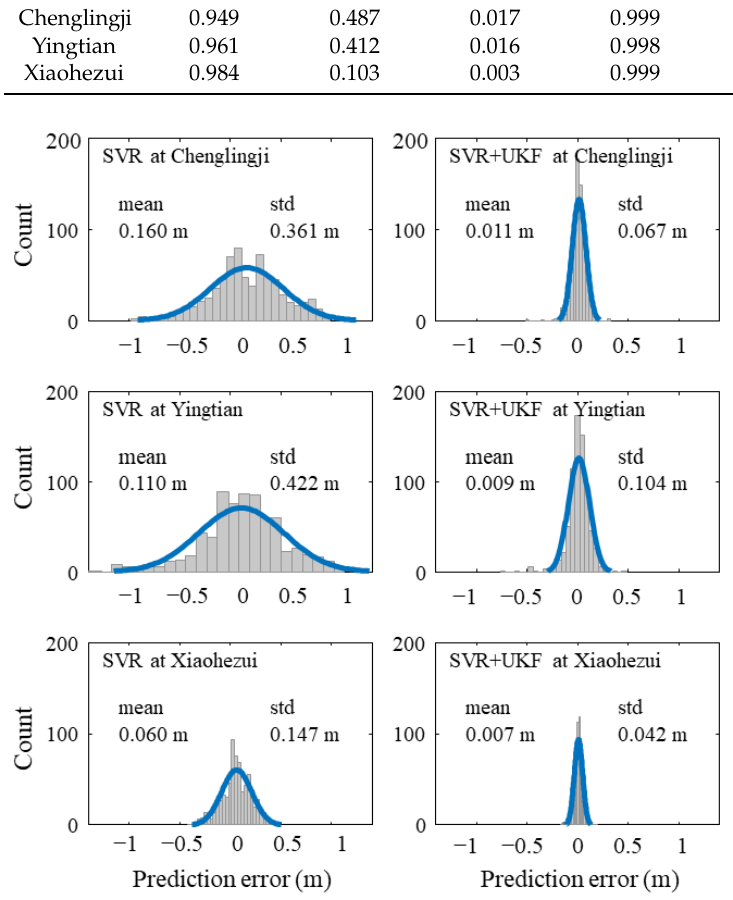
Figure 12. Probabilistic histograms of prediction errors of SVR and SVR+UKF. The mean values for the non-assimilated models at Chenglingji and Yingtian are 0.160 m and 0.110 m respectively, while the mean value for the Xiaohezui model is smaller at 0.060 m. For the assimilated model, the positive and negative distribution of errors is more even, with the mean value of errors at all sites not greater than 0.024 m. Given the small fluctuation range of errors for the assimilated model, the standard deviation of errors is also smaller. The standard deviation of the error is also smaller than that of